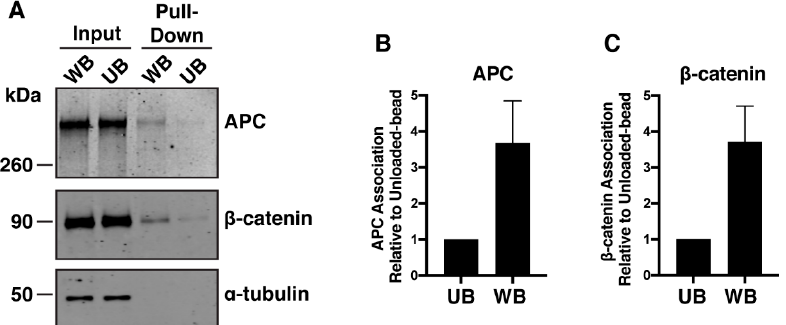
Figure 2. Wnt-beads pull-down APC and β -cat ∆ S45. ( A ) HCT116 β m cells treated with Wnt-beads or Unloaded-beads were lysed and proteins were pulled-down with the beads. Both APC and β -cat ∆ S45 were detected in the Wnt-bead pull-down but not the Unloaded-bead pull-down. ( B ) Quantification of APC pulled-down by Wnt-beads compared to Unloaded-beads from three independent experiments. ( C ) Quantification of β -cat ∆ S45 pulled-down by Wnt-beads compared to Unloaded-beads from three independent experiments. Protein levels that were pulled-down by beads were divided by the respective input protein levels and normalized to the Unloaded-bead to demonstrate fold change. Error bars, standard deviation (SD)Full blots, Figure S2).